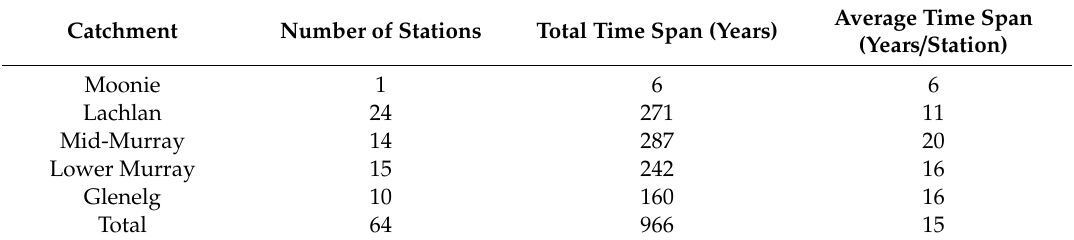
Table 2. Water temperature data used for temperature simulations in the five catchments. The total time span is the sum of all available data for a specific